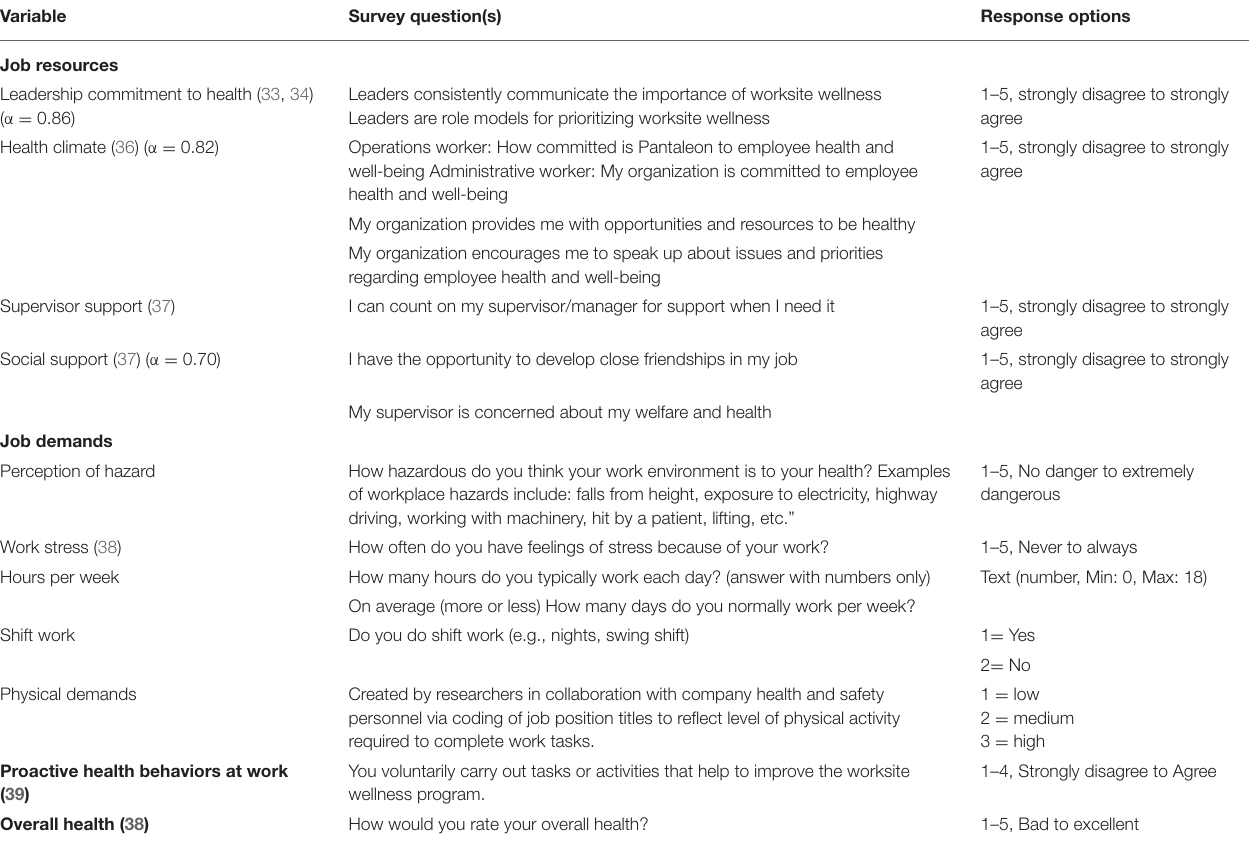
TABLE 1 | Survey measures. Variable Survey question(s) Response